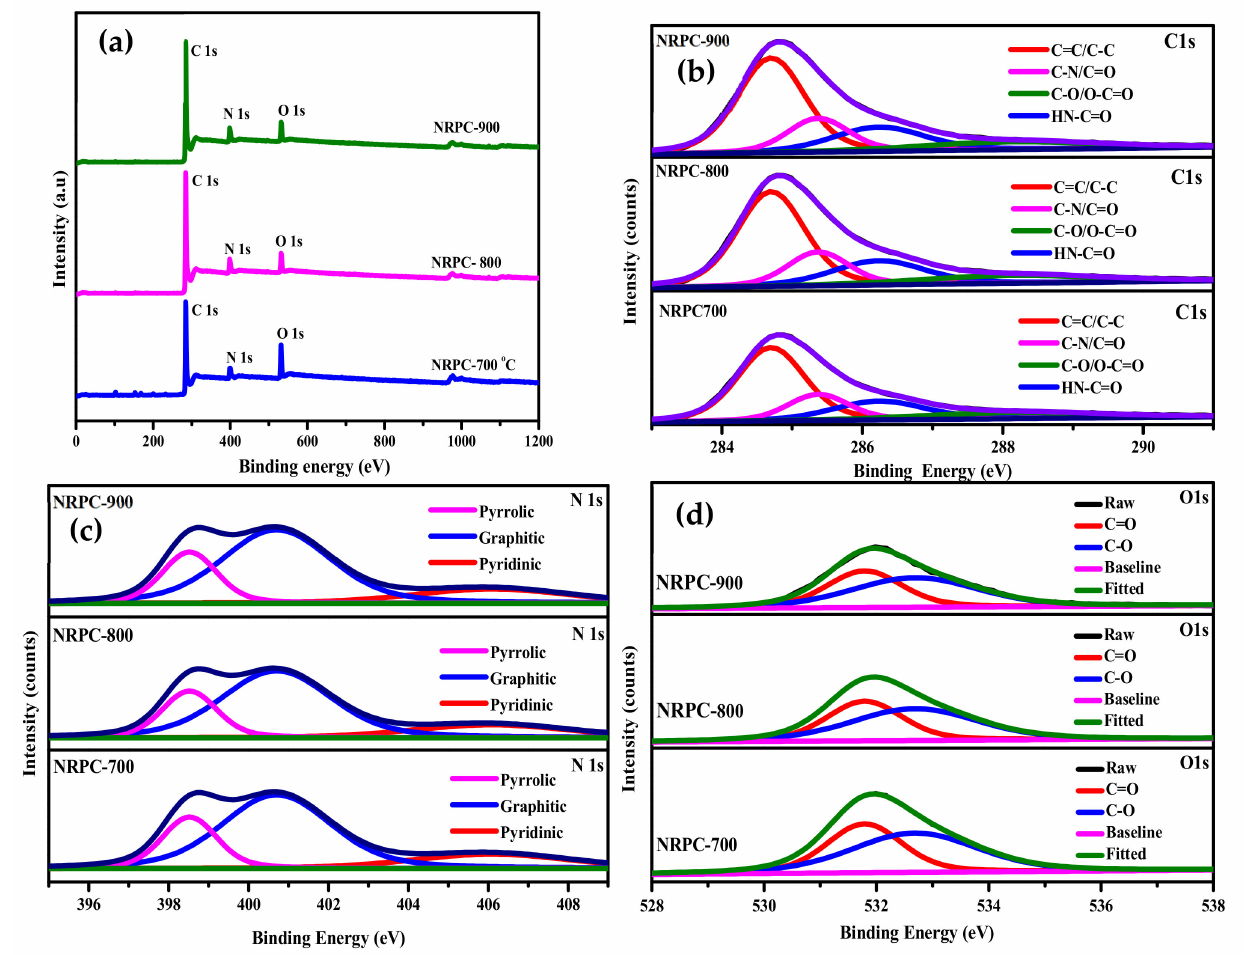
Figure 5. ( a ) XPS spectra and ( b – d ) C1s, N1s and O1s spectra of